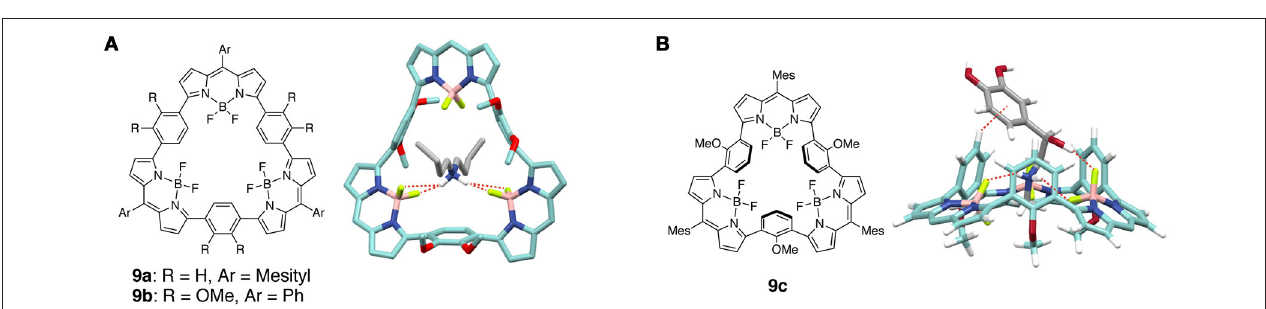
Frontiers in Chemistry |